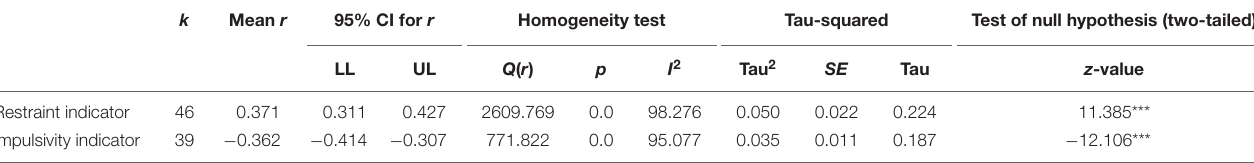
TABLE 2 | Random model of correlations between self-control and Internet